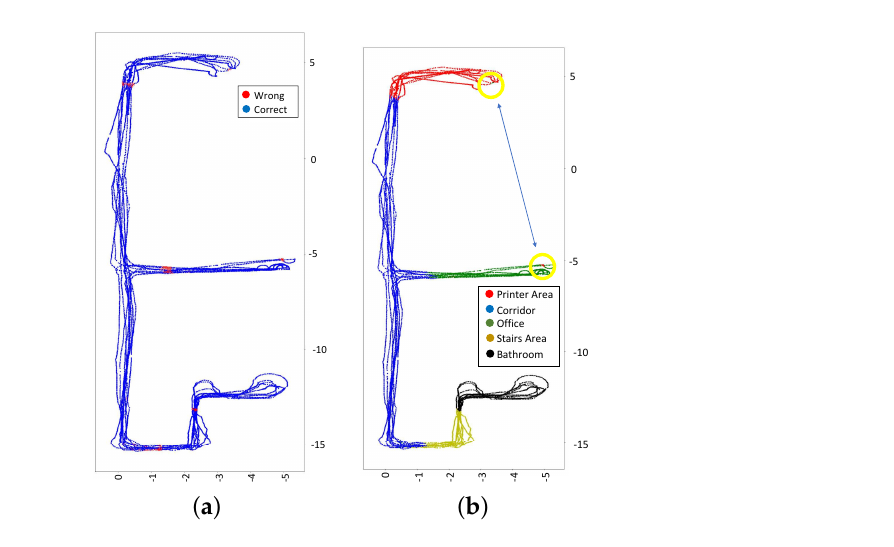
Figure 3. Trajectory maps. ( a ) The correct (blue) and the wrong (red) retrievals tackled by the developed CNN. ( b ) The room retrievals done along the trajectory. Each room has been assigned a different color (e.g., the red color indicates the images that have been retrieved by the CNN as belonging to the printer area). Apart from the expected mistakes in the transition areas, there is some confusion between the printer area (red color) and the office